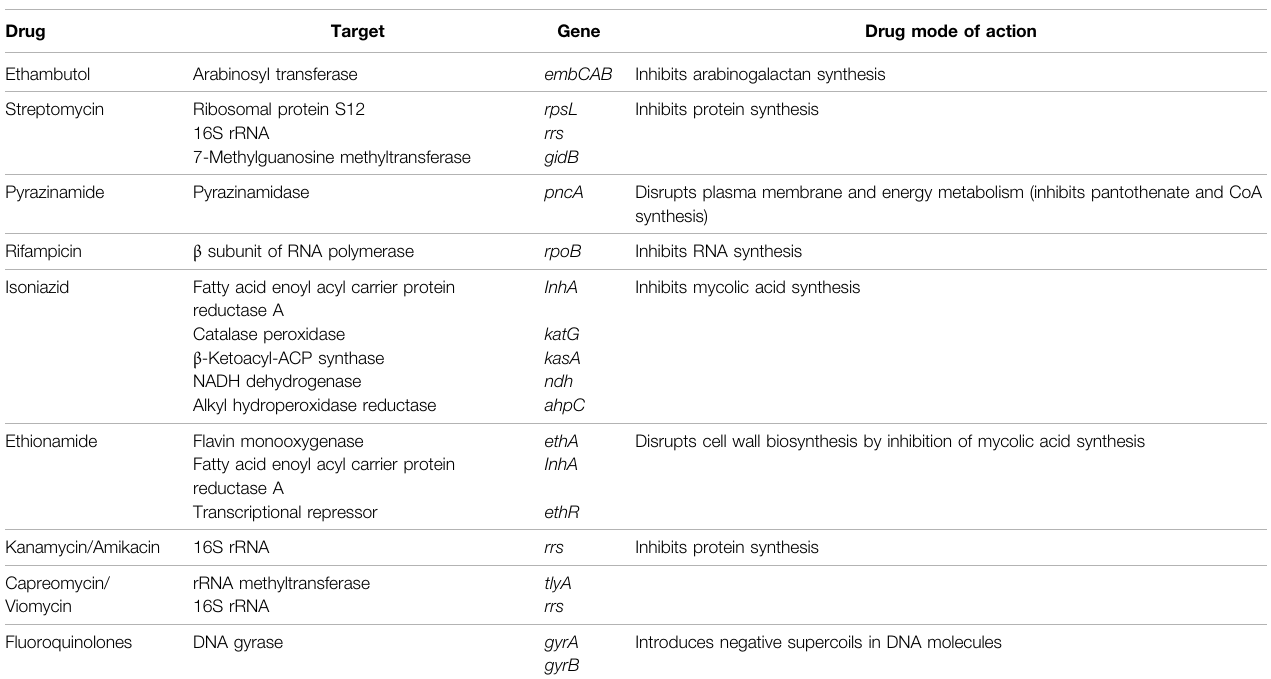
TABLE 1 | Drug targets and the mode of action (Louw et al., 2009; Zhang and Yew, 2009).